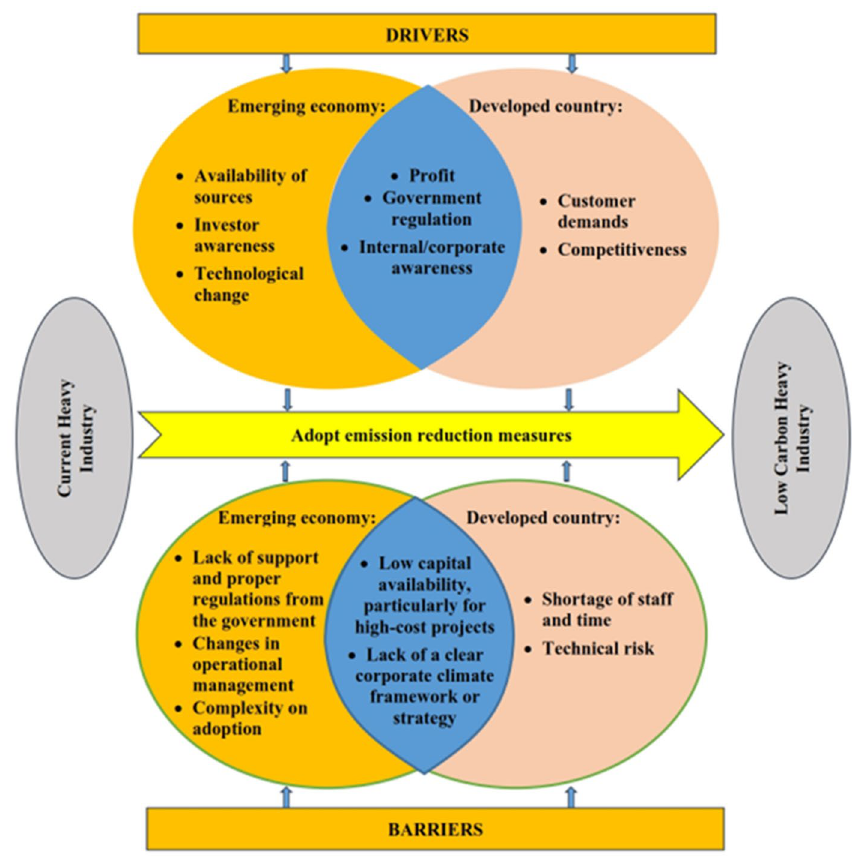
Figure 2. Conceptual diagram depicting factors which influence the decision to adopt emission reduction potential in heavy industry in an emerging economy and developed